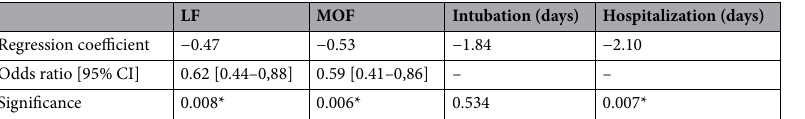
Table 4. Influence of early operative treatment (≤ 5 days) on outcome parameters. Regression model includes: age, sex, ISS,